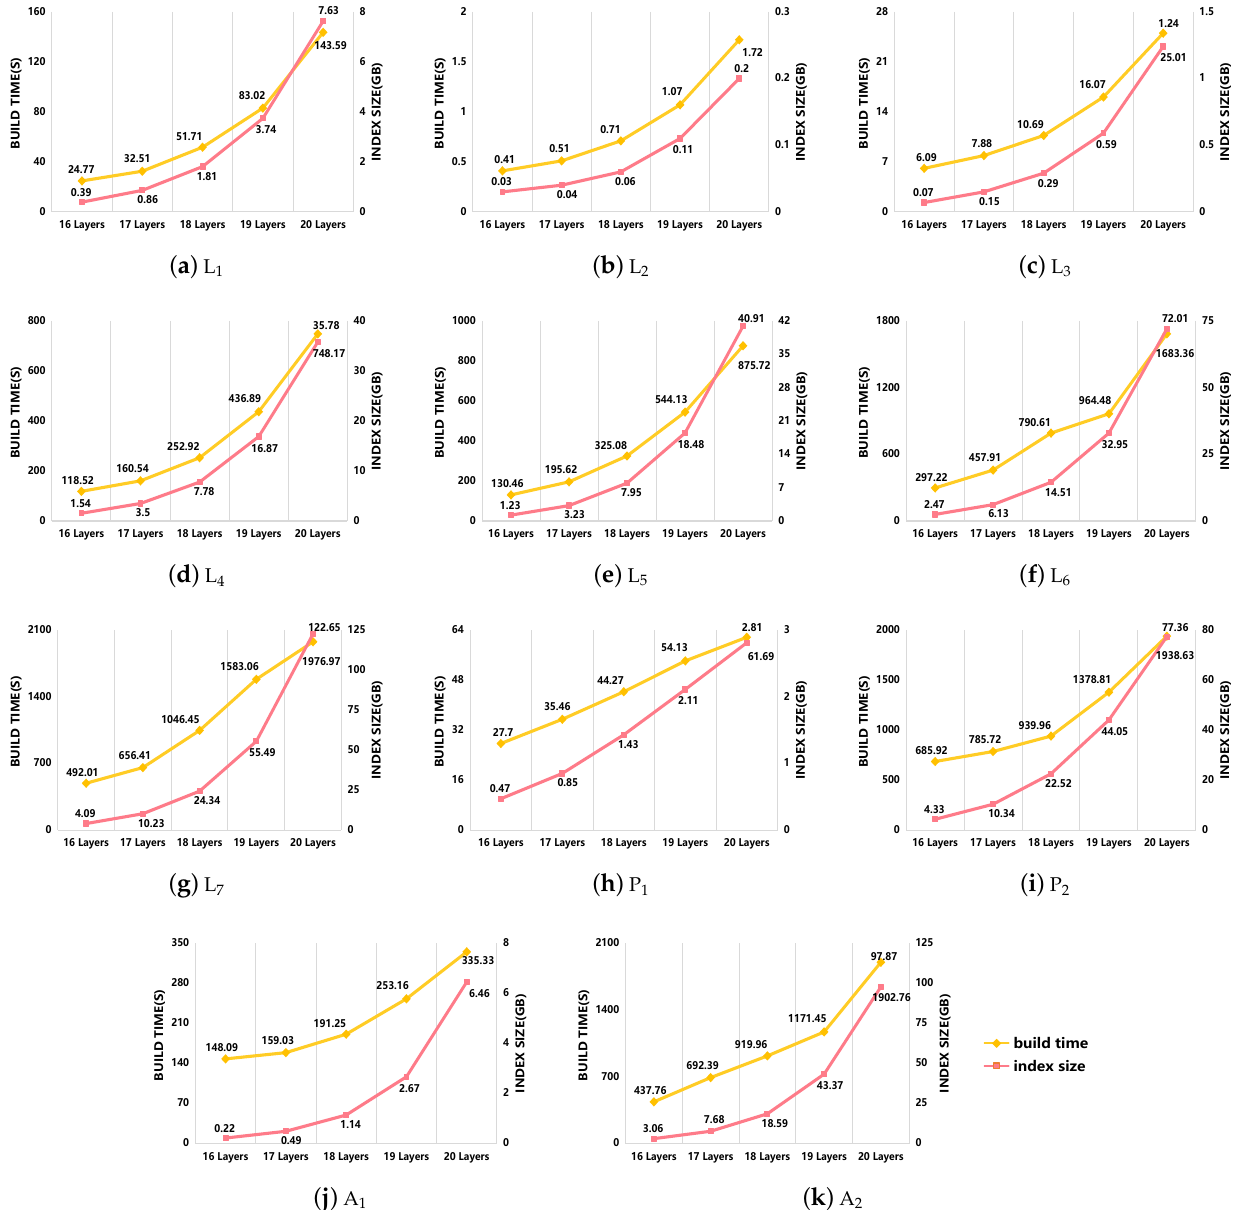
Figure 12. Index build time and index size when TQ-tree is built with 16–20